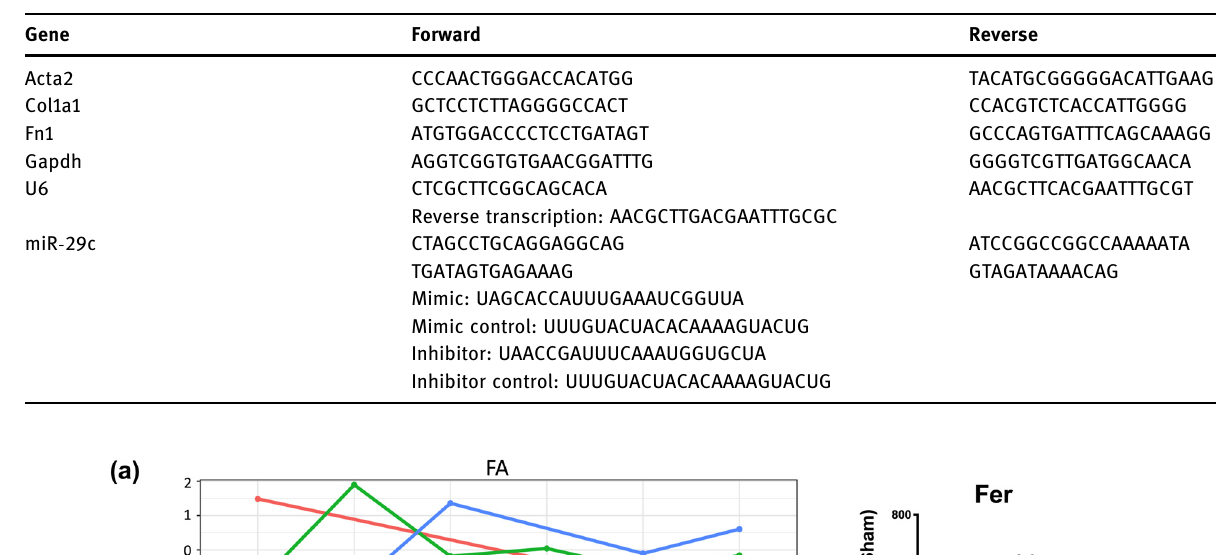
Table 1: Primers used in the study ( 5 ′ to 3 ′ )